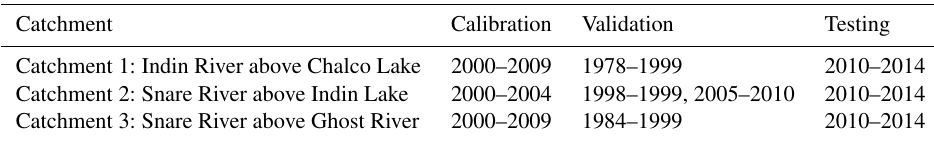
Table 1. Calibration, validation and testing periods.